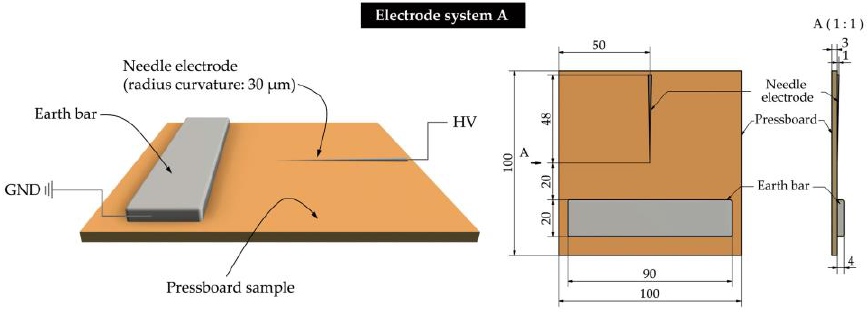
Figure 4. The applied electrode system for generation of surface discharges on pressboard sample in oil with a negligibly small normal component of electric field — electrode system A.